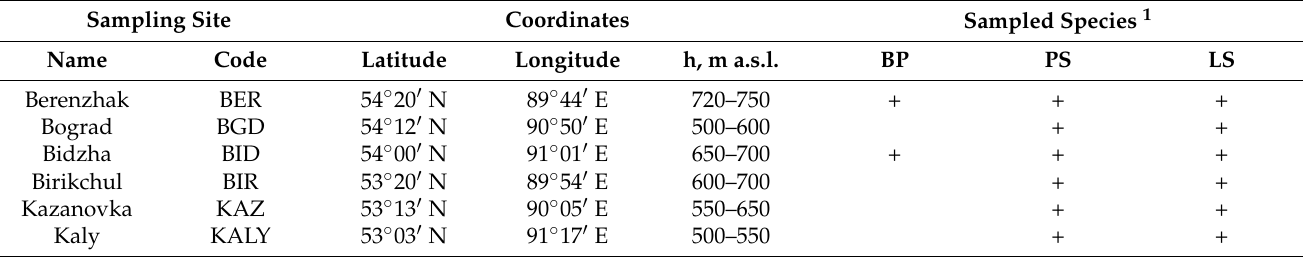
Table 1. Sampling sites and tree